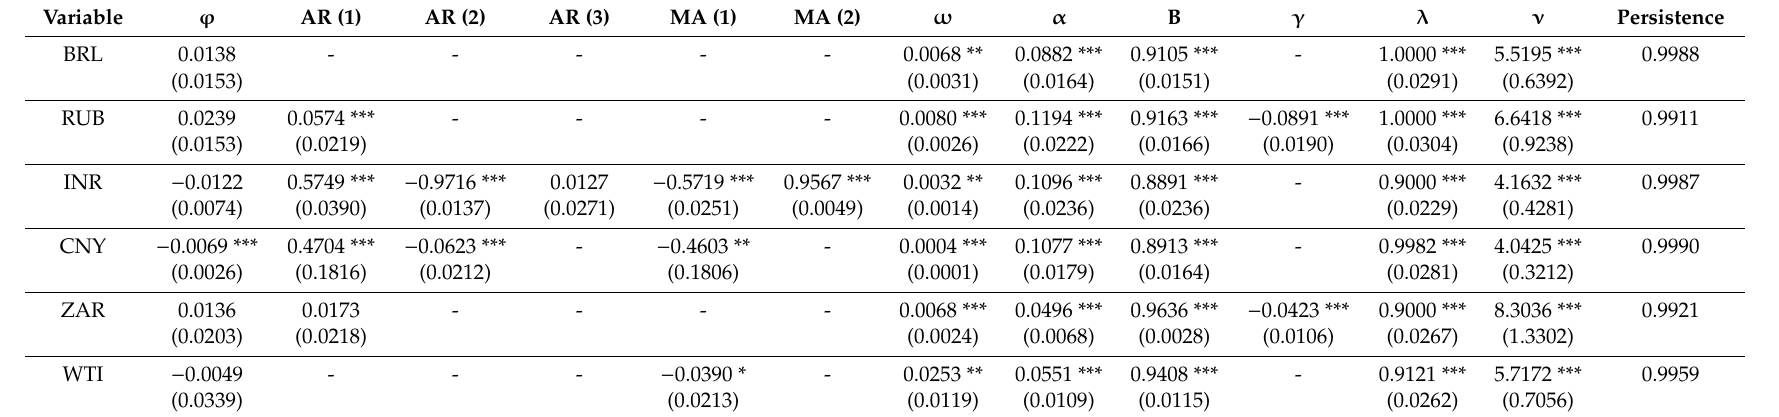
Table A1. Marginal distribution parameter